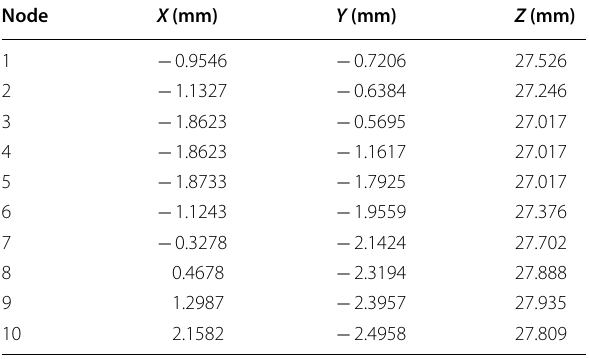
Table 2 Turbine blade damage model node coordinate set